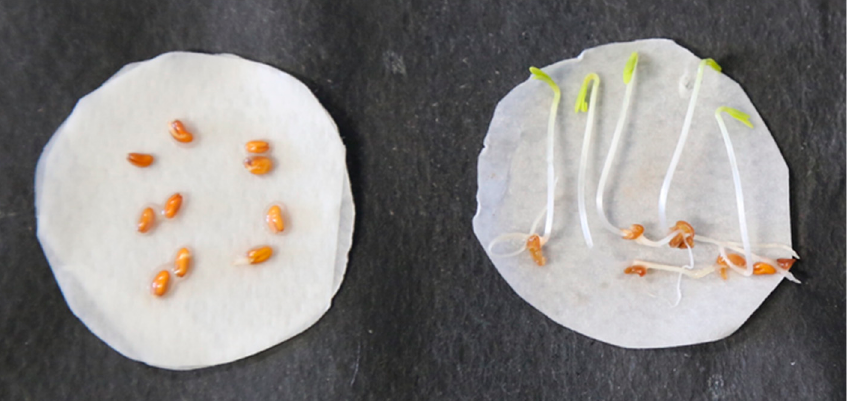
Figure 6. Inhibition of rootlet elongation of cress plants induced by Es extract ( left ). Control (distilled H 2 O, right ).